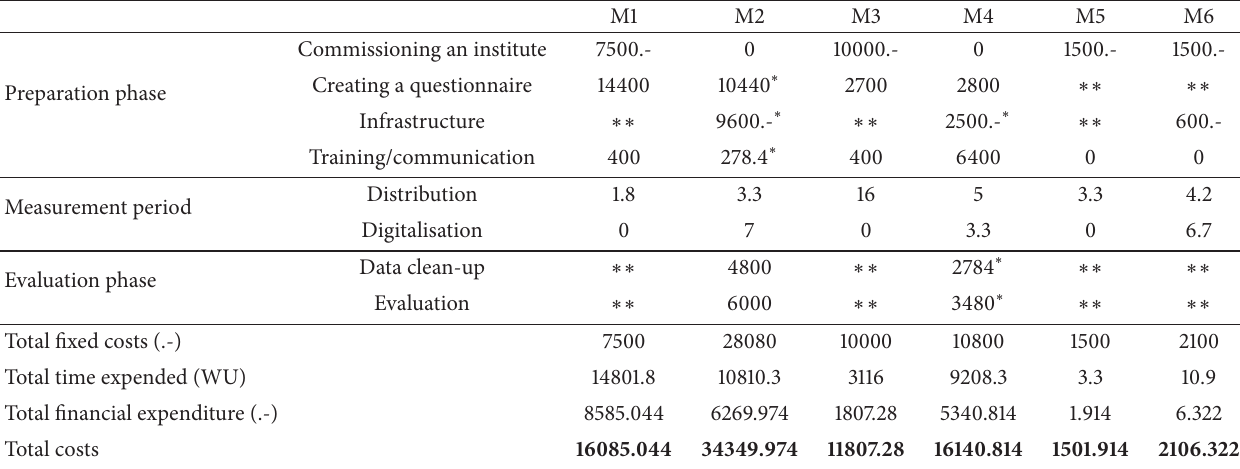
Table 3: Financial expenditure and time